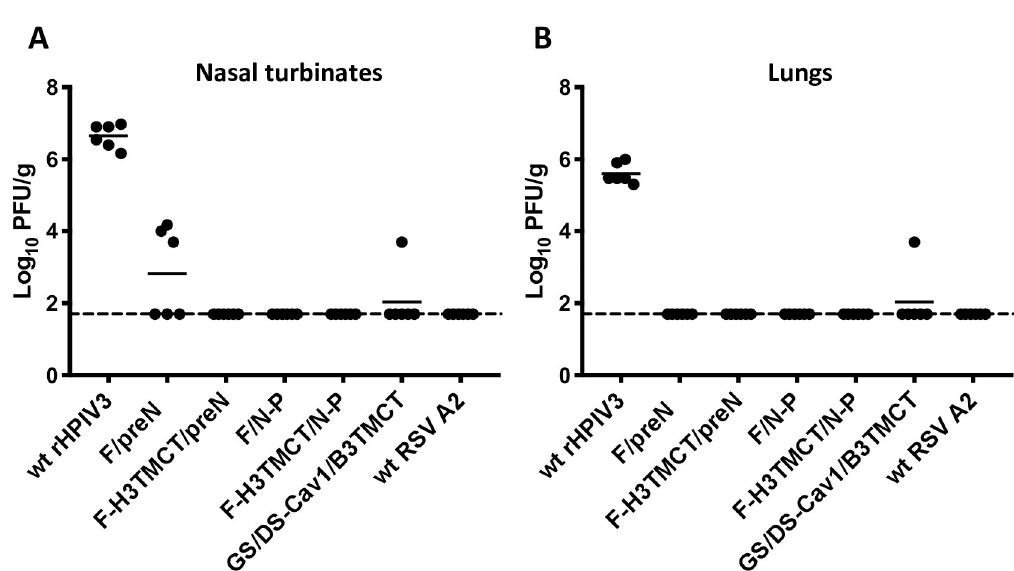
Fig 8. Protection of hamsters against wt RSV challenge. Hamsters immunized with the indicated viruses in the experiment described for Fig 7 were challenged IN with 10 6 PFU of wt RSV at day 30 post-immunization. The animals were sacrificed on day 3 post-challenge, and the titers of challenge virus in the nasal turbinates (A) and lungs (B) were determined by immunoplaque assay. The RSV titer is shown for each hamster (filled circles) with the group mean titer indicated by a horizontal line. Dashed line indicates the assay detection